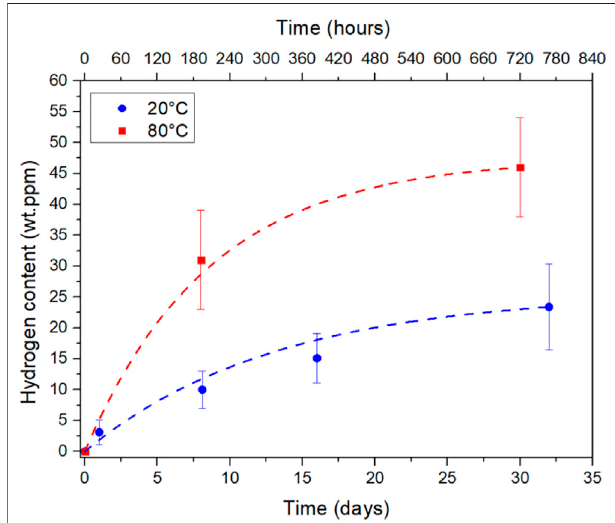
SCE. The error bars indicate the standard deviation obtained using three to fi ve samples in each case.